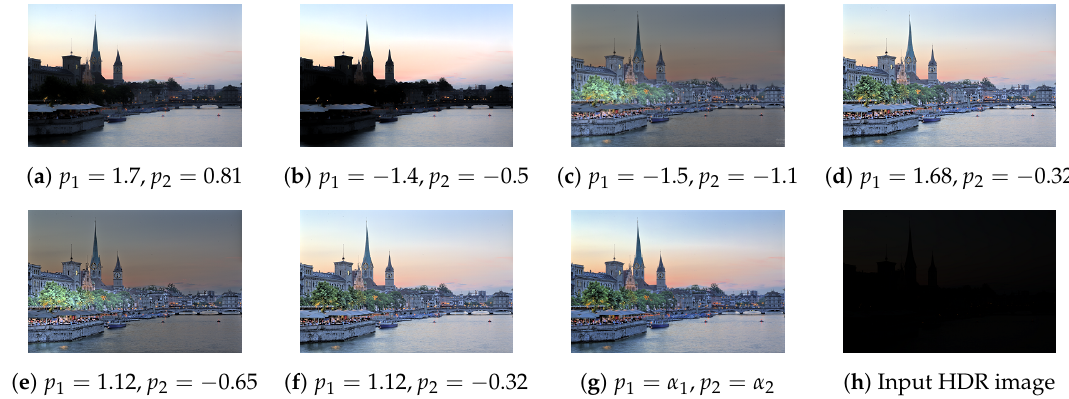
Figure 5. Effect of parameters on tone mapping. The subfigures show the following scenarios: ( a ) p 1 and p 2 increase towards the positive infinity, ( b ) p 1 and p 2 increase in magnitude and tend towards the negative infinity, ( c ) p 1 increases towards the positive infinity, and p 2 tends towards the negative infinity, ( d ) p 2 is fixed, and p 1 increases towards the positive infinity, ( e ) p 1 is fixed, and p 2 tends towards the negative infinity, ( f ) original parameters from [36], ( g ) proposed parameters α 1 = 1 + σ , α 2 = − α 1 /4; where, σ is the standard deviation of the respective image, and ( h ) input HDR image. The tone-mapped image is brighter because of the fixed parameters, and our adaptive settings produce a more realistic image than do the fixed parameter